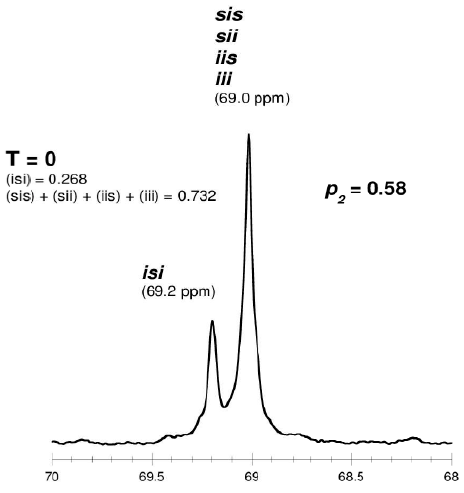
Figure 2. 13 C-NMR spectra of “predominantly isotactic” PLA (methine region) ( p 2 = 0.58, PLA 25 ).